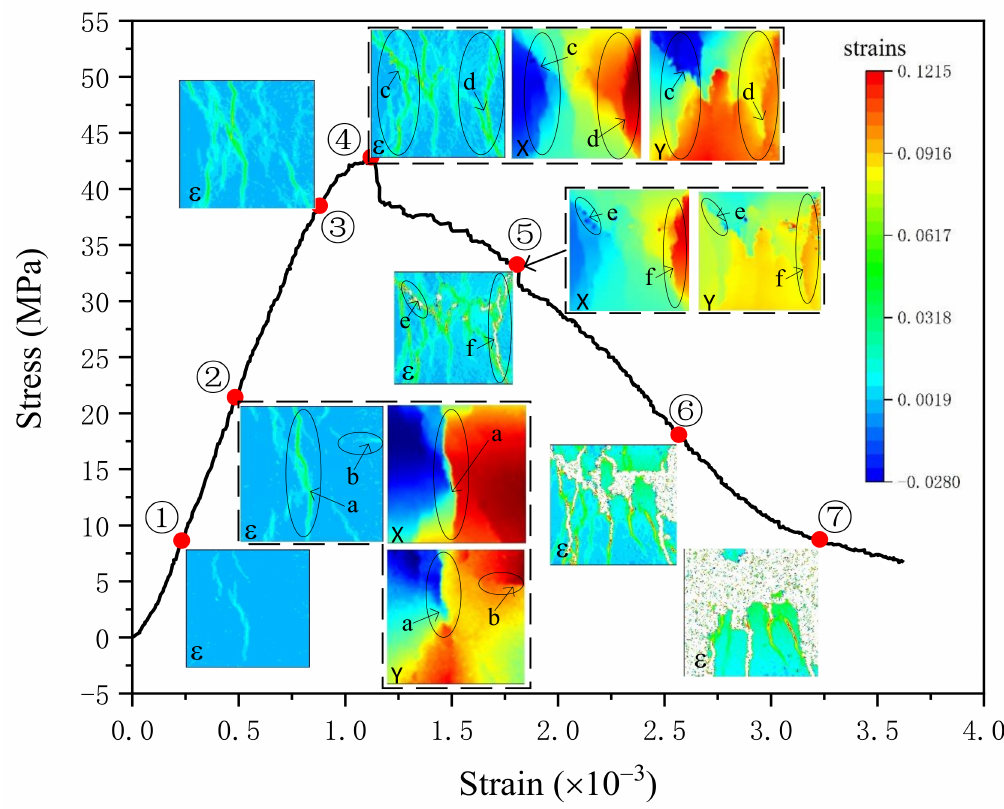
Figure 8. Strain and displacement contours of the experiment: (cid:192) – (cid:199) are the contours at different load stages; a − f are different